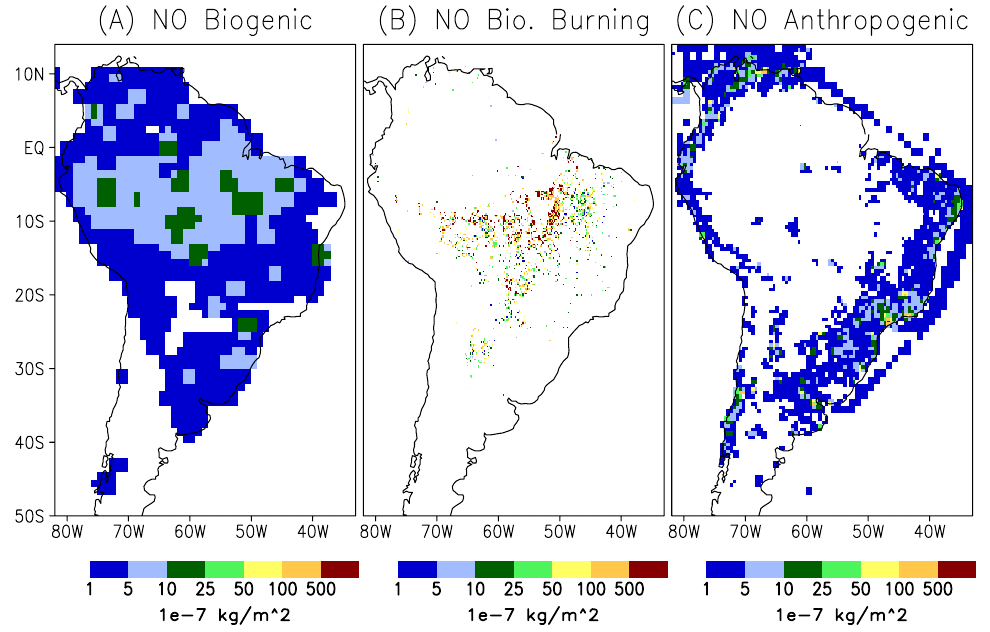
Fig. 6. Different sources of NO estimated for 27 August 2002 on a rectangular projection grid with spatial resolution of 0.2 ◦ × 0.2 ◦ . Panel (A) represents biogenic emission following GEIA inventory, (B) biomass burning NO emission from 3BEM and (C) anthropogenic NO using RETRO data but updated with local sources of information for the South American main